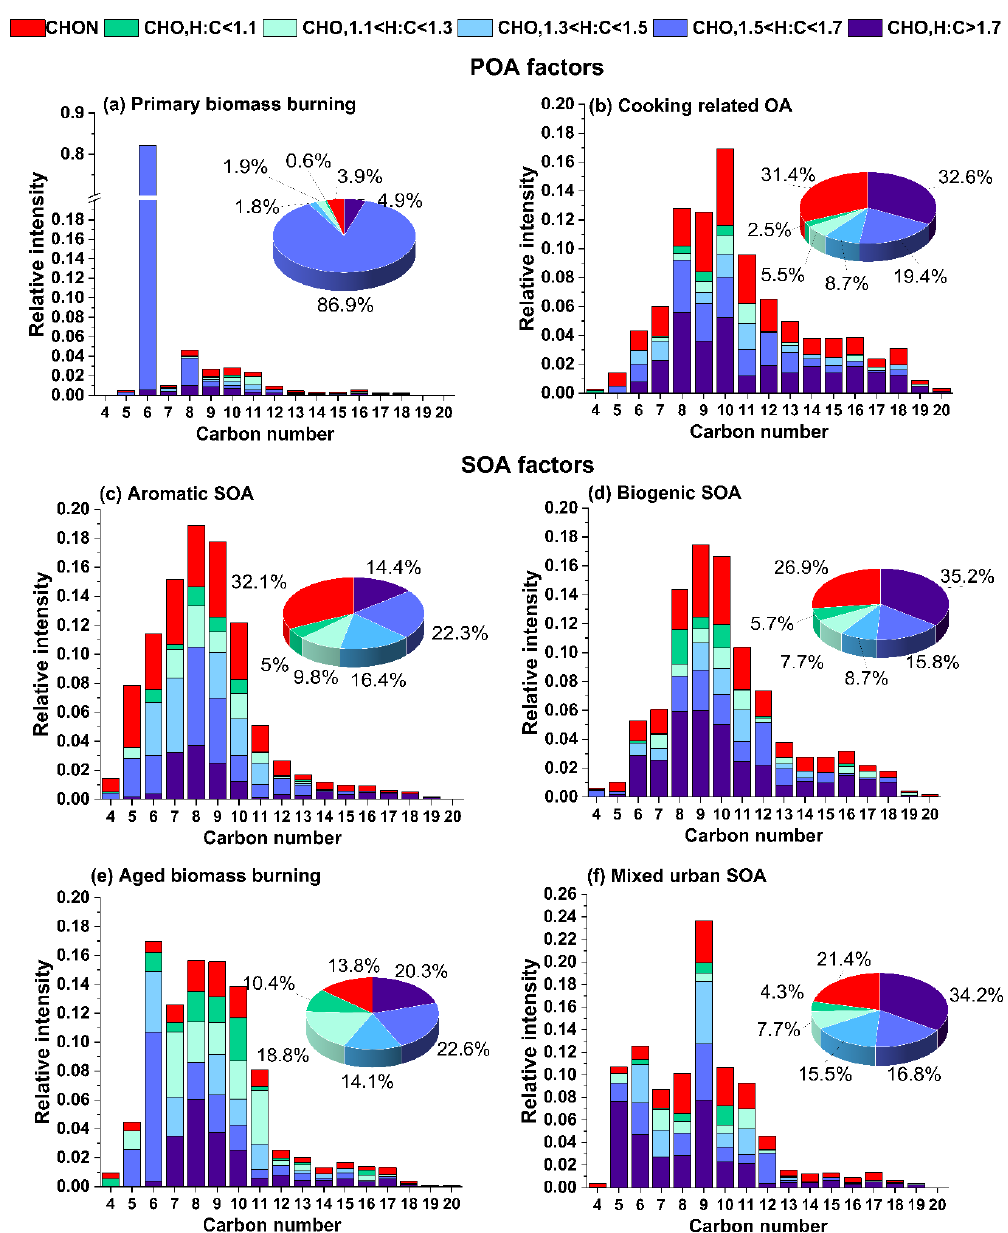
Figure 3. Carbon number distribution plots of EESI-TOF factors. Each carbon number contribution is stacked by contributions from CHON species (red) and CHO species segregated by their H : C ratio categories. The green-to-blue colour gradient represents C x H y O z com- pounds classified by H : C ratios of H : C < 1.1, 1.1 < H : C < 1.3, 1.3 < H : C < 1.5, 1.5 < H : C < 1.7, and H : C > 1.7, and red denotes C x H y O z N 1 − 2